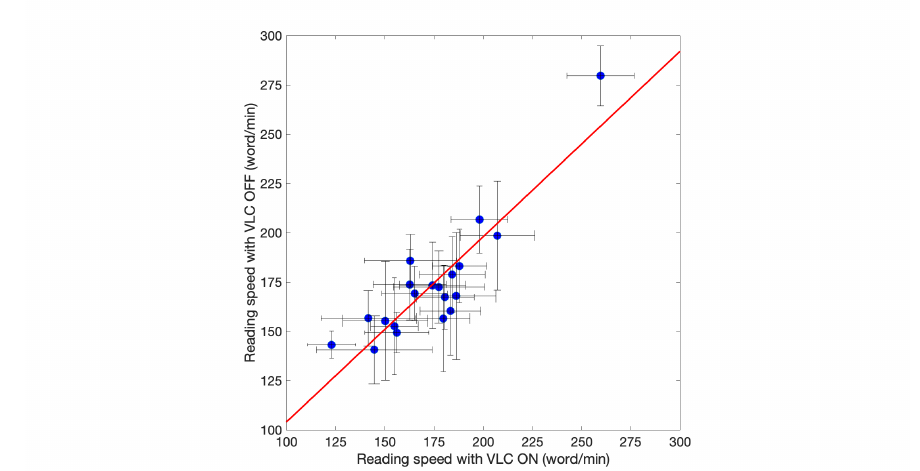
Figure 6. Scatter plot between v ON ˘ σ ON and v OFF ˘ σ OFF for each examined subject when taking the REX test. The figure also displays the linear regression fit, represented by the equation y “ 1.02 x ´ 4.60, and the Pearson correlation coefficient R “ 0.97. It can be noted that there is a positive correlation between v ON and v OFF .